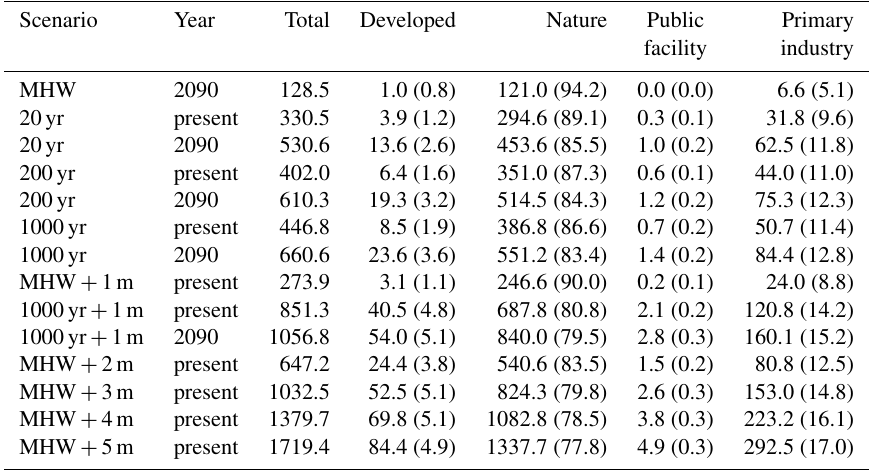
Table 2. Affected areas (km 2 ) in Norway under different water levels at present and for 2090. Numbers in parentheses indicate the percentage share of the total for each subcategory. Note that the areas for present MHW have been subtracted from the numbers for higher water levels.